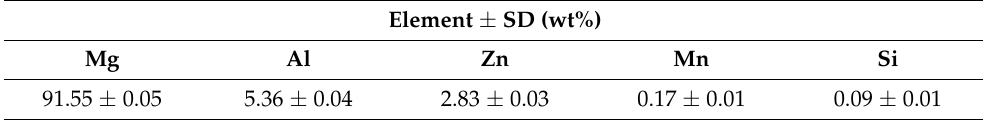
Table 3. EDS area scan quantitative chemical elemental analysis of raw Mg alloy.